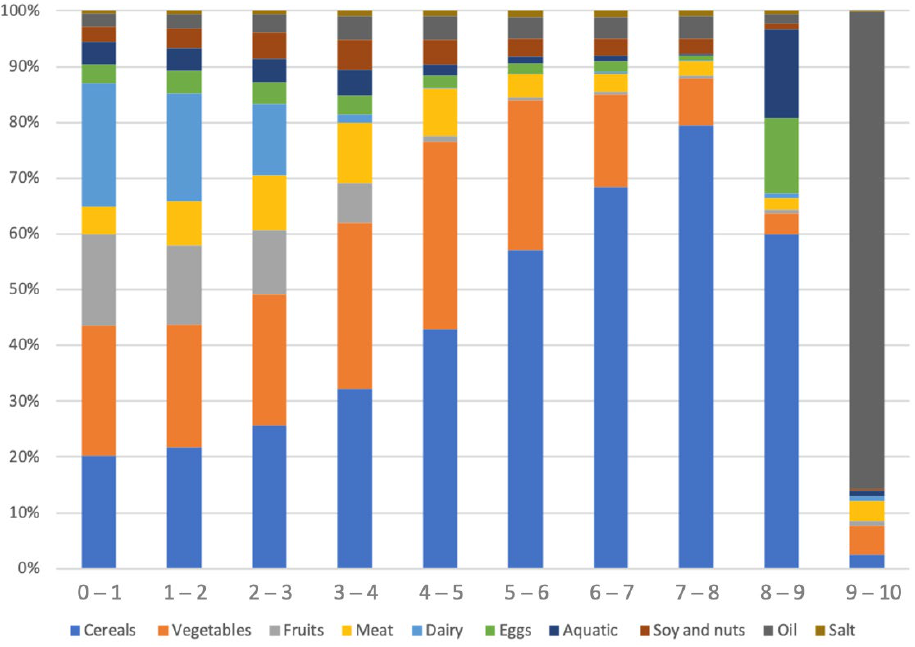
Figure A2. The schematic of the classification of the population according to Diet Adherence Score category. The central circle represents the Chinese Dietary Guideline (CDG). The surrounding dots represent people in the sampled population. The distance from each individual to the CDG is the distance in a 10 - dimensional space from each individual ’ s intake of 10 food groups to the median of the intake range specified in the CDG.